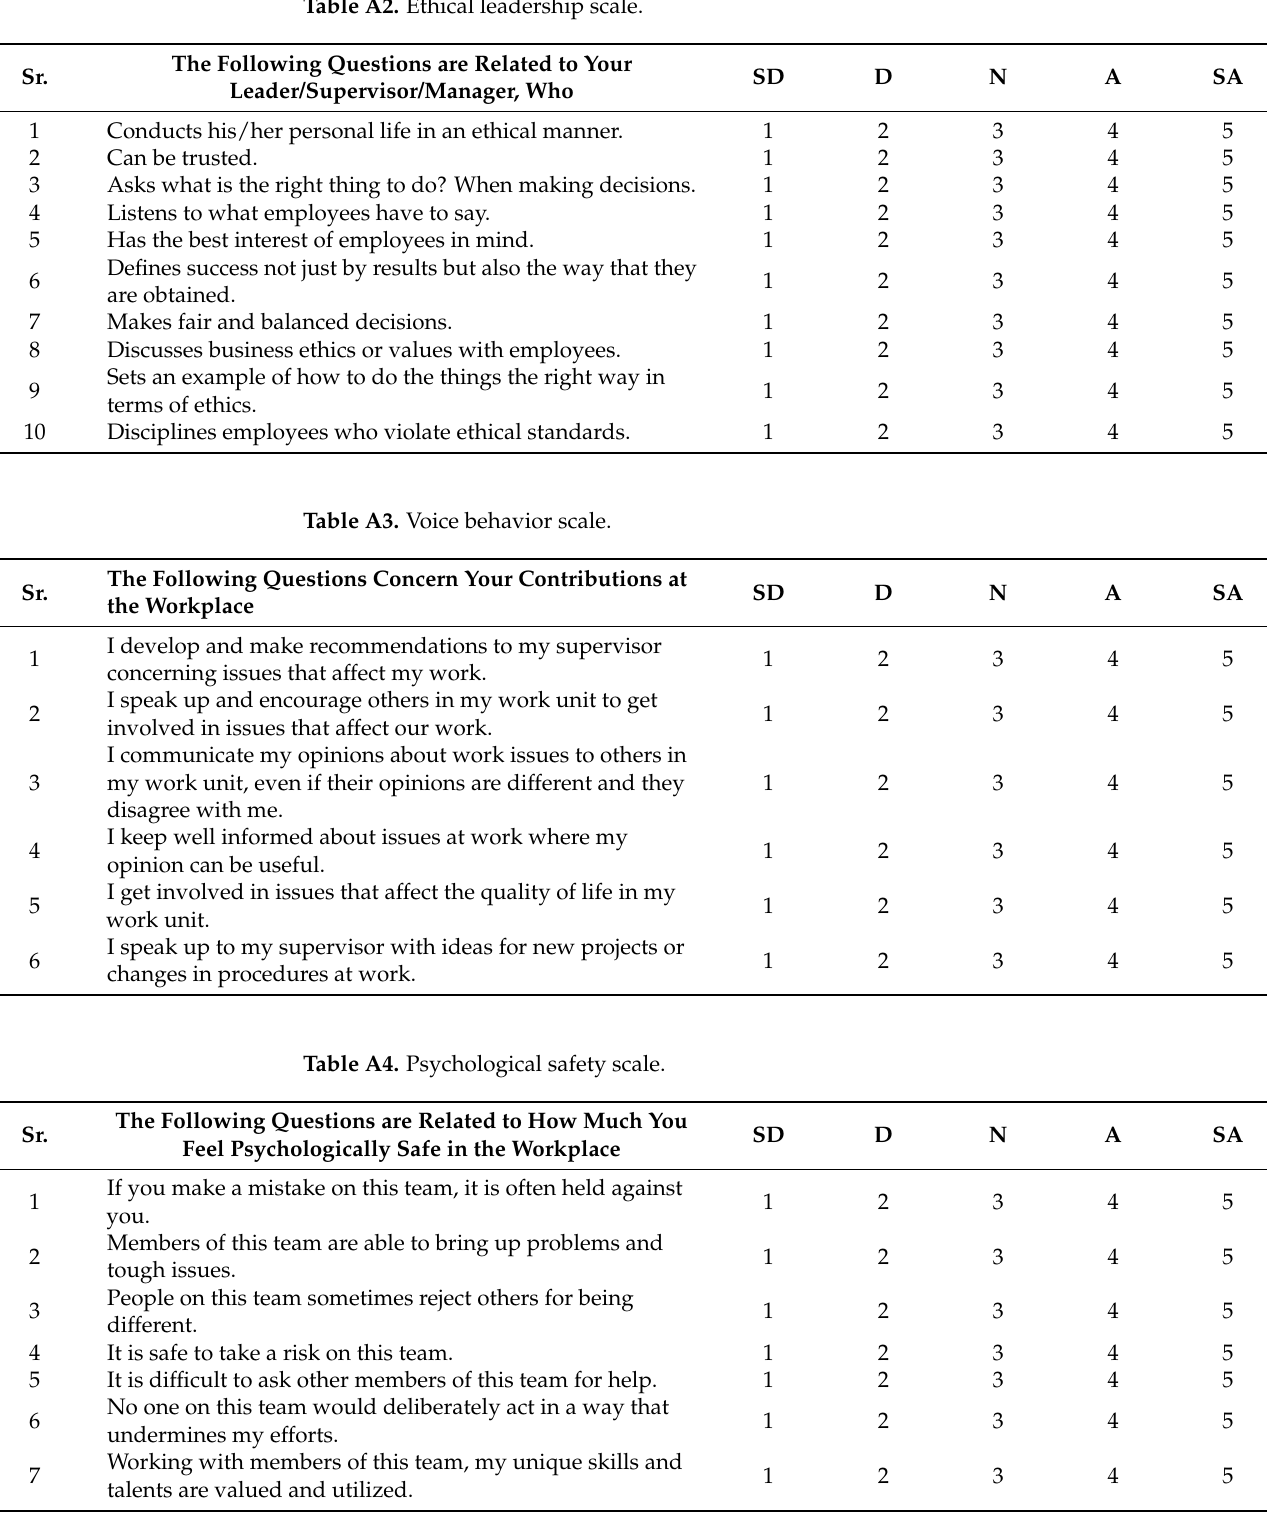
Table A2. Ethical leadership scale.